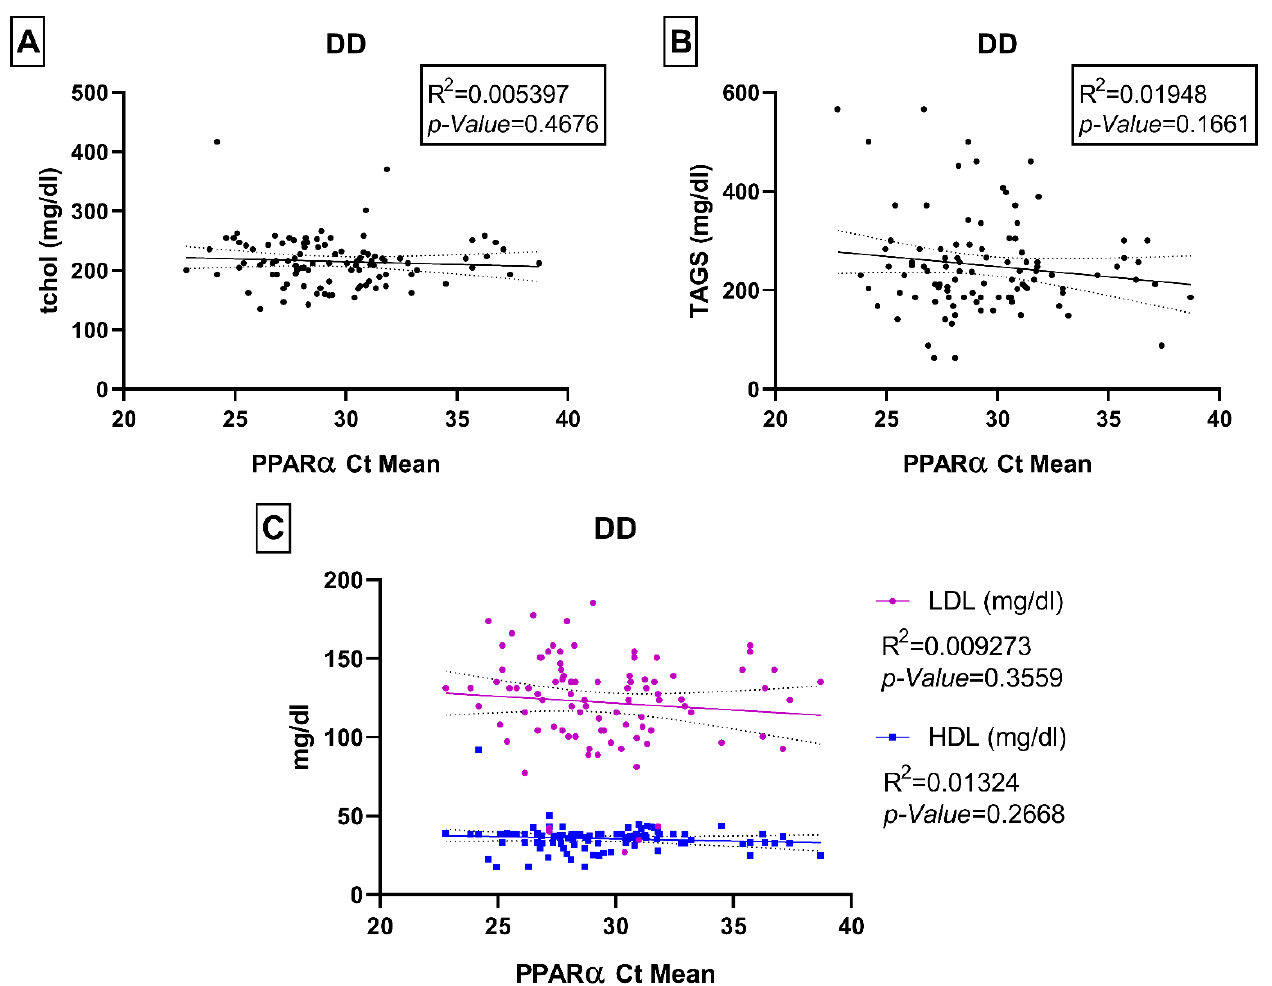
Figure 7. Relationship between PPAR α Ct mean and biomedical parameters of total serum cholesterol (tchol mg/dl) ( A ), serum triglycerides (TAGS mg/dl) ( B ), low-density lipoprotein (LDL mg/dl) ( C ) and high-density lipoprotein (HDL mg/dl) ( D ) in DD group. Each dot of the scattered plot represents the data of individual participants.